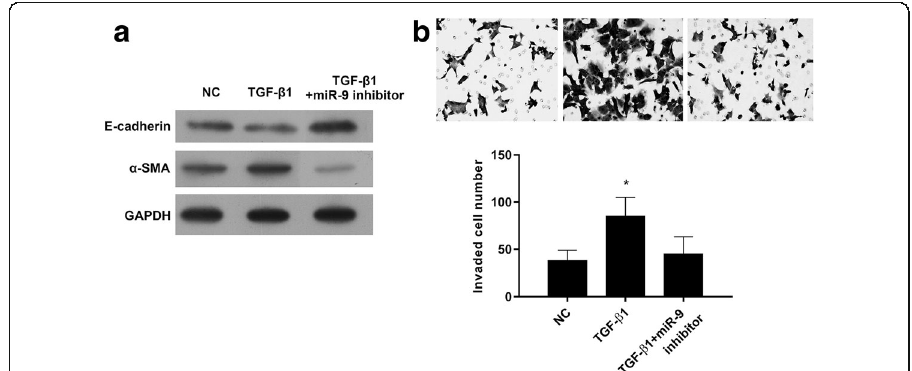
Fig. 5 miR-9 inhibitors inhibit TGF- β 1-induced EMT. After transfection with miR-9 inhibitors for 24 h, the cells were treated with TGF- β 1 (5 ng/ml) for 24 h. a – The expression levels of α -SMA and E-cadherin were detected using western blot. b – Cell invasion was detected using a Transwell assay. * p < 0.01 vs.